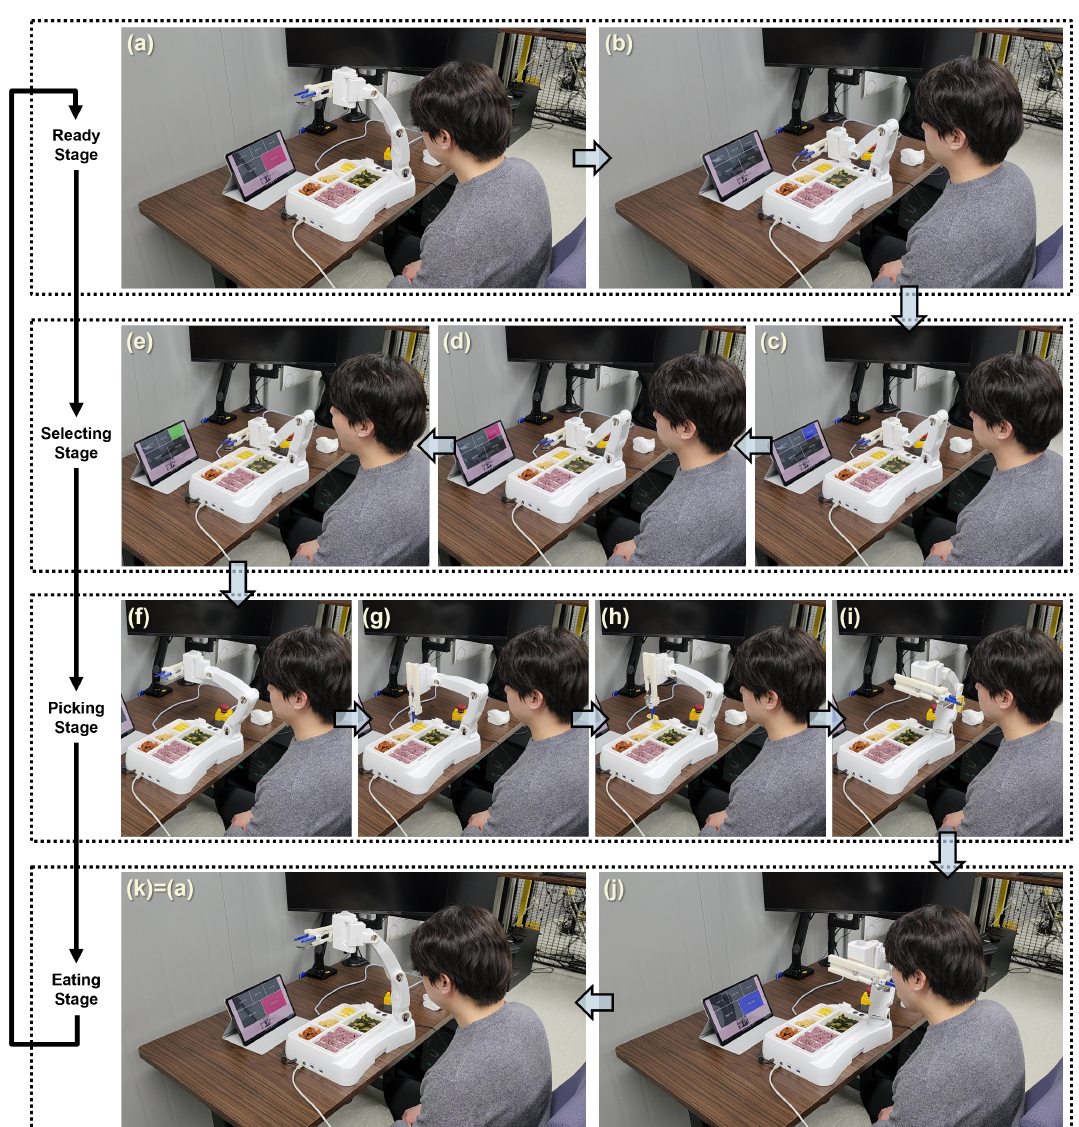
Figure 14. Demonstration of the actual use of the proposed MAR system. ( a ) The robot arm returns to the ready position and takes an image of the food tray. ( b ) After taking the image, the robot moves to the standby position, transfers acquisition points for each side dish to the robot controller and waits for the user’s command. ( c ) Food selection stage 1. ( d ) Food selection stage 2. ( e ) Once